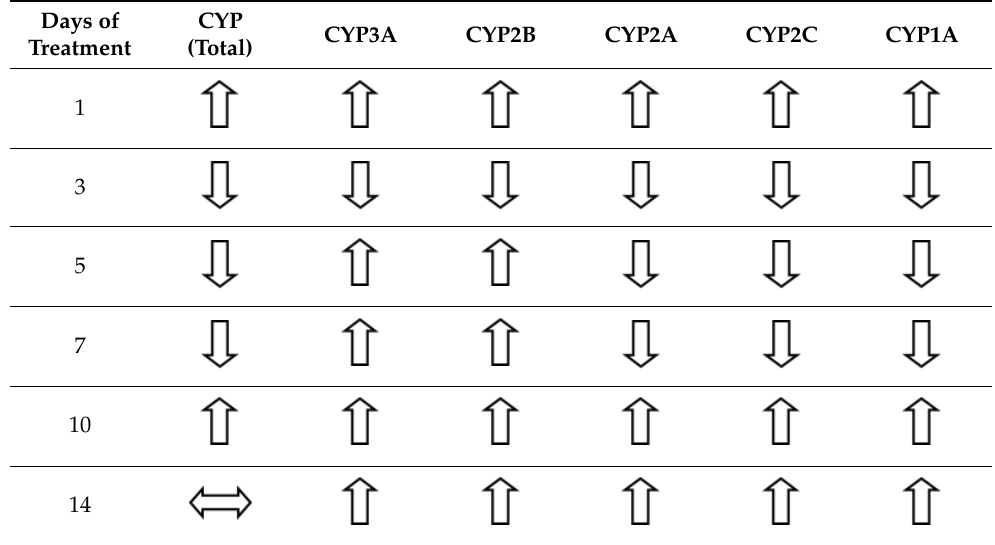
decrease, increase, unchanged, NT not tested. Based on [42] .